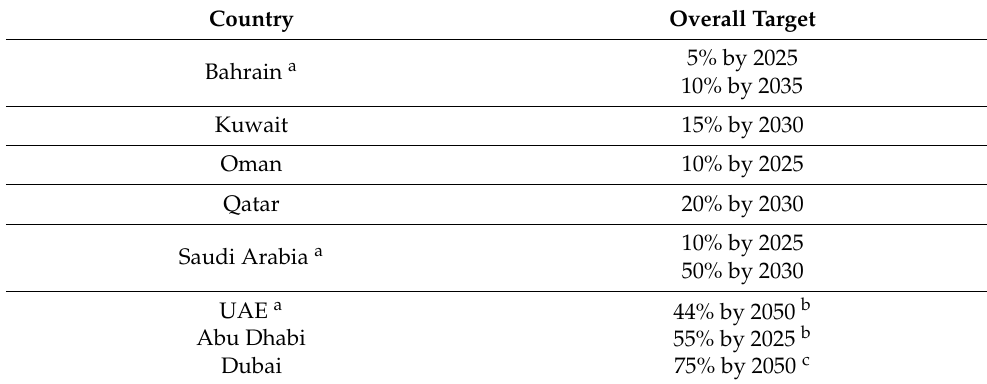
Table 1. Renewable energy power generation targets in Gulf